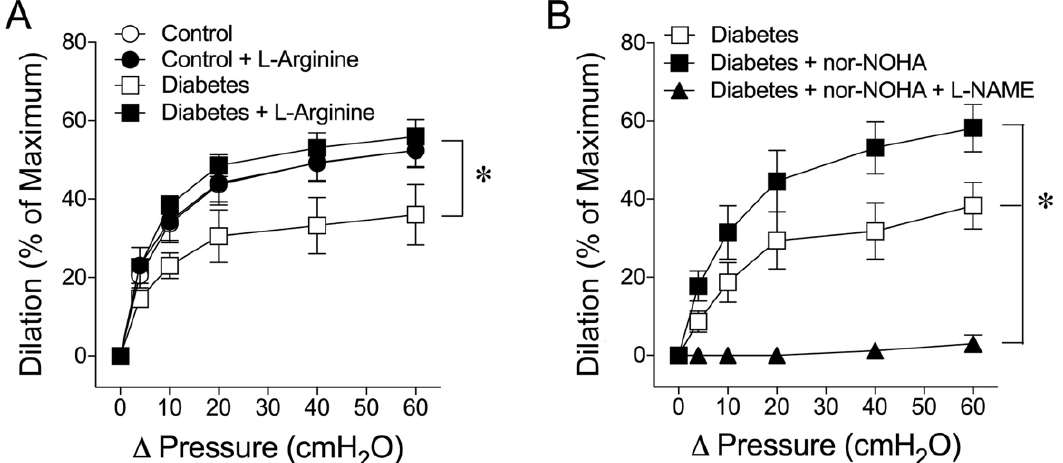
Figure 4. The impacts of L-arginine availability and arginase activity on flow-induced dilation were evaluated in coronary arterioles from pigs with and without diabetes. ( A ) Administration of L-arginine (3 mmol/L; n = 6) did not alter flow-induced dilation in the control vessels (n = 6) but the impaired vasodilation by diabetes (n = 5) was restored by L-arginine (n = 5). ( B ) The blunted flow-induced dilation in diabetic vessels (n = 6) was reversed by arginase inhibitor nor-NOHA (0.1 mmol/L; n = 6). Co-incubation with nor-NOHA and L-NAME abolished the flow-induced dilation of coronary arterioles in diabetic pigs (n = 4). The resting vascular tones were not altered before and after L-arginine in either control (59 ± 4% vs. 58 ± 3%) or diabetic (62 ± 3% vs. 63 ± 4%) vessels. nor-NOHA also did not alter the resting tone in diabetic vessels (62 ± 3% vs. 62 ± 4%). * p < 0.05 vs. diabetes.